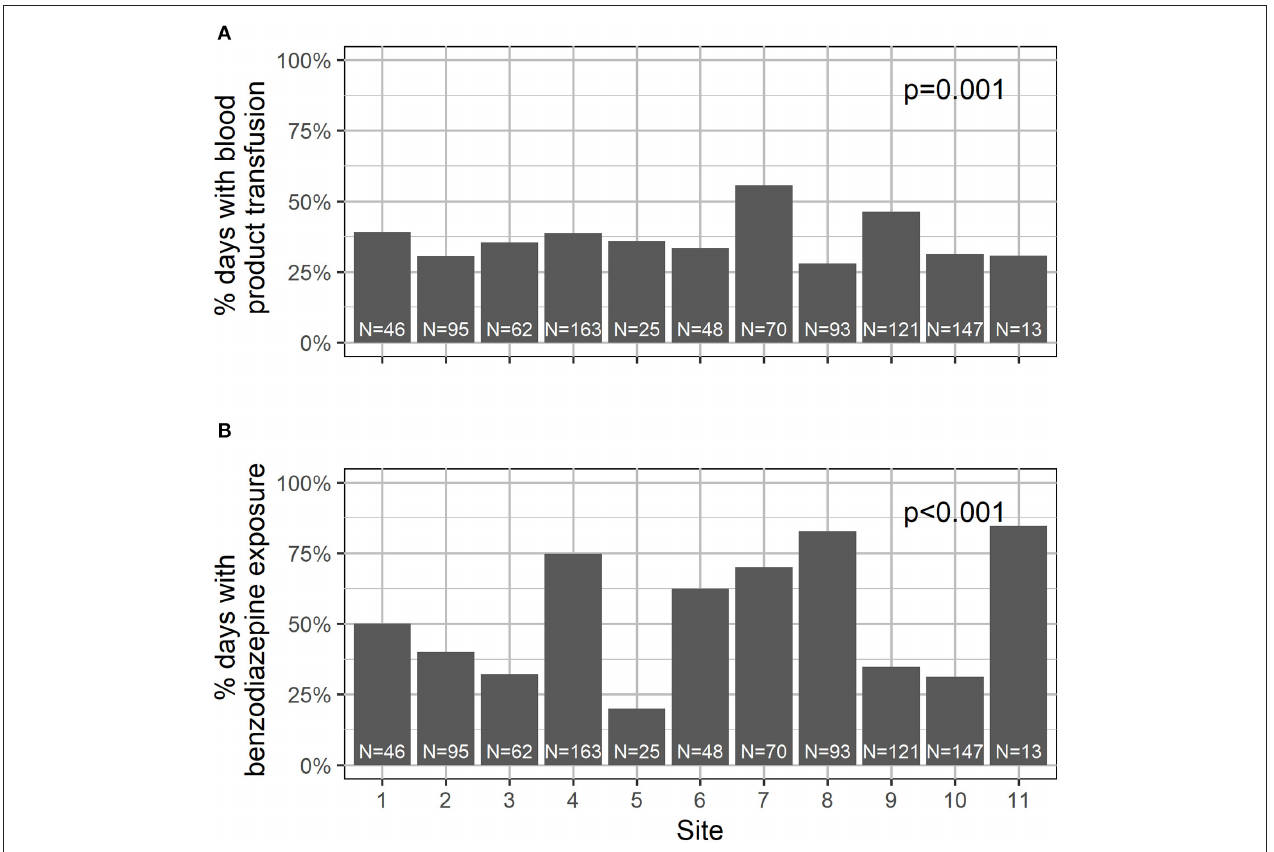
FIGURE 2 | Transfusion ( A ) and benzodiazepine ( B ) use differed significantly by